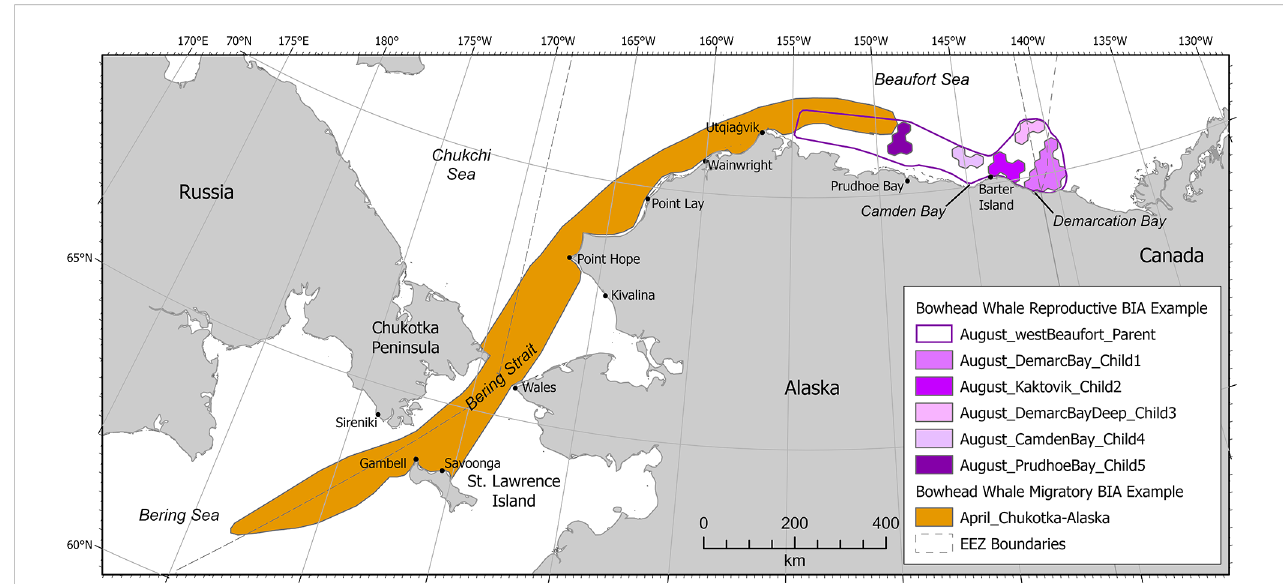
FIGURE 3 Example Arctic region BIAs showing bowhead whale transboundary-international (Bowhead Whale Migratory) and hierarchical (Bowhead Whale Reproductive)